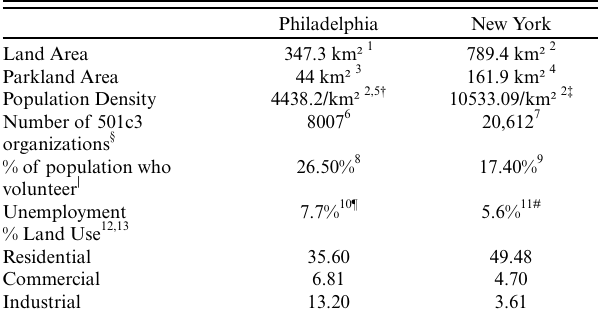
Table 1 . Descriptive comparison of Philadelphia and New York; demographic data drawn from same year as network data collection where